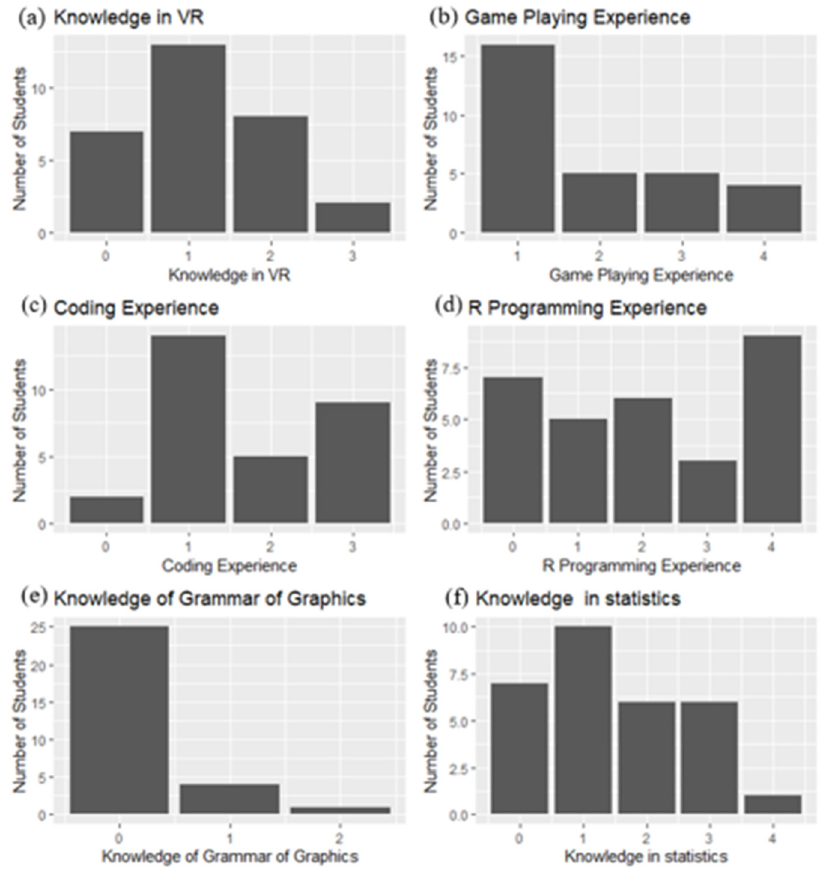
Figure 15. Background information ( a ) Participants’ VR technology knowledge distribution. ( b ) Participants’ video game-playing experience distribution. ( c ) Participants’ coding experience dis- tribution. ( d ) Participants’ R programming knowledge distribution. ( e ) Participants’ grammar of graphics theory knowledge distribution. ( f ) Participants’ analytics knowledge distribution.